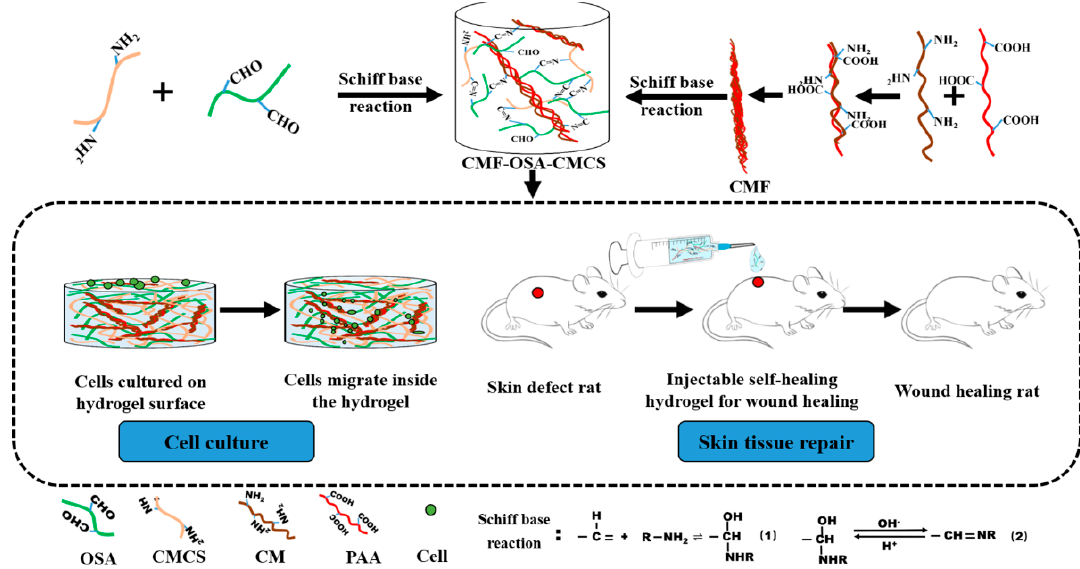
Figure 1. Design flow chart for preparing fiber mesh hydrogel and schematic of cell animal experiment. OSA, oxidized sodium alginate; CMCS, carboxymethyl chitosan solution; CM, chitosan; PAA, polyacrylic acid.